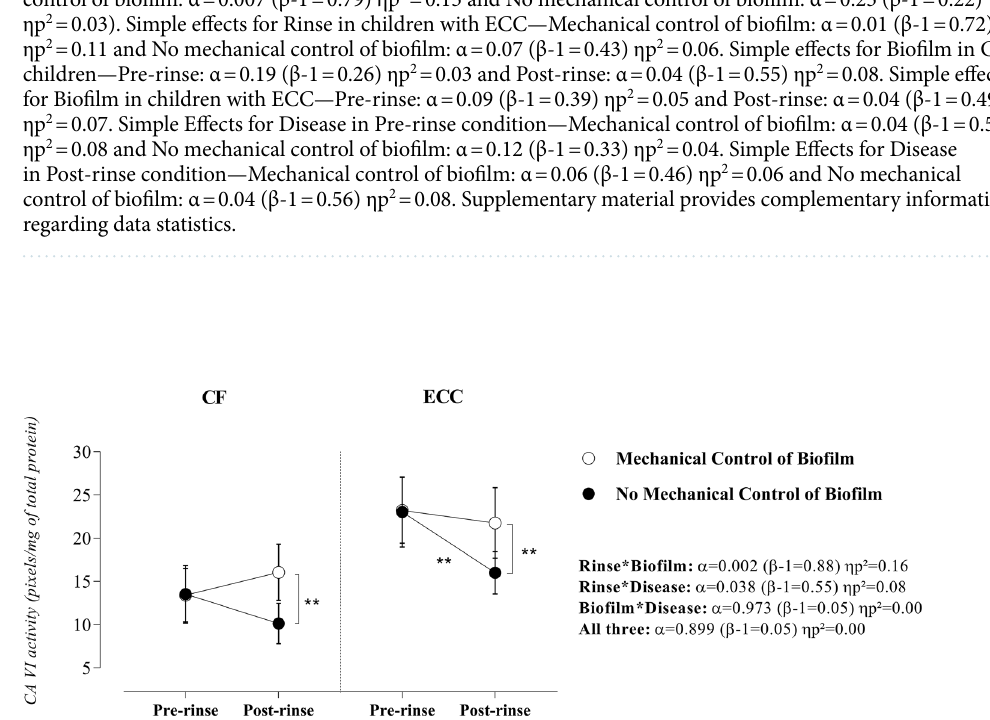
Figure 4. Effect of rinse, mechanical control of biofilm, and disease on salivary CA VI activity. Statistical analyses were performed with a sample of 56 volunteers, 28 per group. ηp 2 : Partial eta squared. Data plotted as mean and standard deviations (due to Gaussian distribution). Considering the presence of significant interactions, the main effects of rinse, disease, and biofilm were suppressed. A single asterisk represents a significant p-value ≤ 0.05. A double asterisk represents a p-value ≤ 0.01. Simple effects for Rinse in CF children— Mechanical control of biofilm: α = 0.15 (β-1 = 0.30) ηp 2 = 0.04 and No mechanical control of biofilm: α =